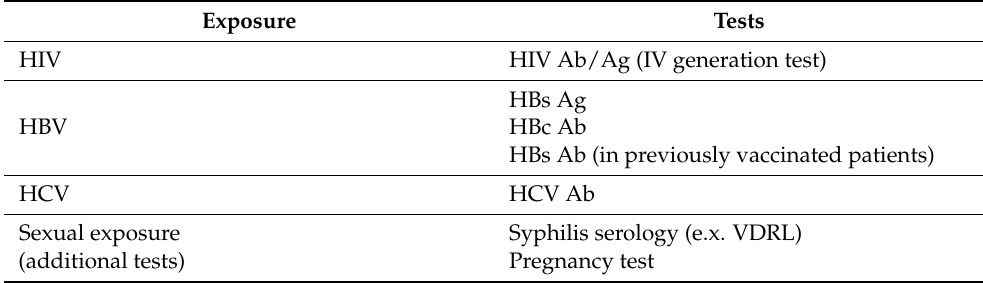
Table 3. Patient’s initial testing universal recommendations